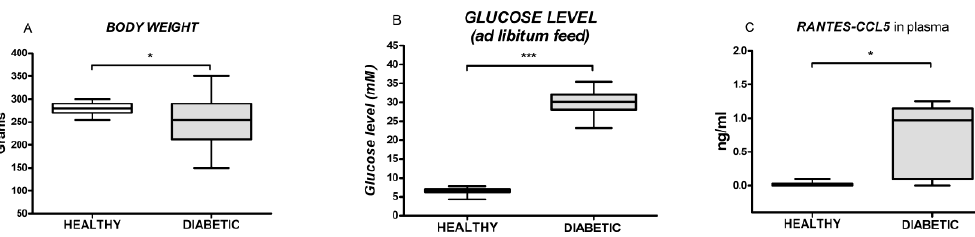
Figure 2. Box and whiskers plots showing body weight, the blood glucose level and the plasma level of RANTES-CCL5 in healthy and diabetic animals. The upper and the lower hinge of the boxes represent the interquartile range, the midline represents the median value, and the whiskers represent the maximum and minimum values. * p < 0.05, *** p < 0.001.